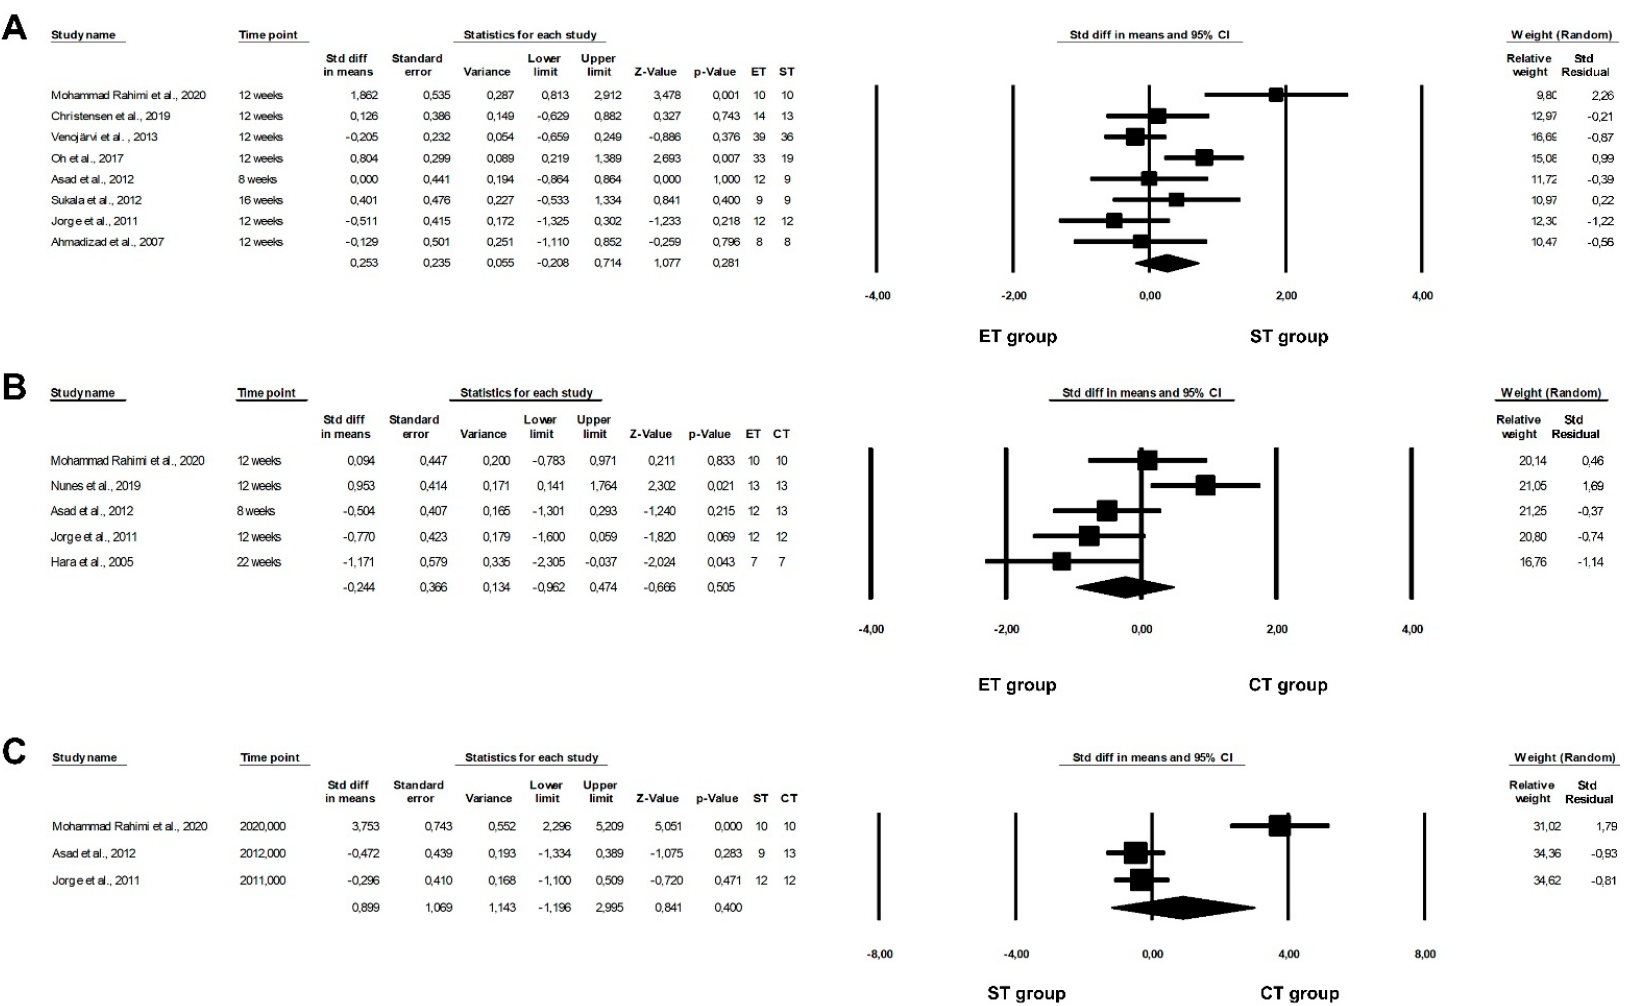
Figure 6. Forest plots of the effect of different training programmes on adiponectin levels: ( A ) ET vs. ST—random model; ( B ) ET vs. CT—random model; ( C ) ST vs. CT—random model. CI—confidence interval; CT—combined training; ET—endurance training; ST—strength training; Std diff—standard differences [19–22,25,40–42,45,47].